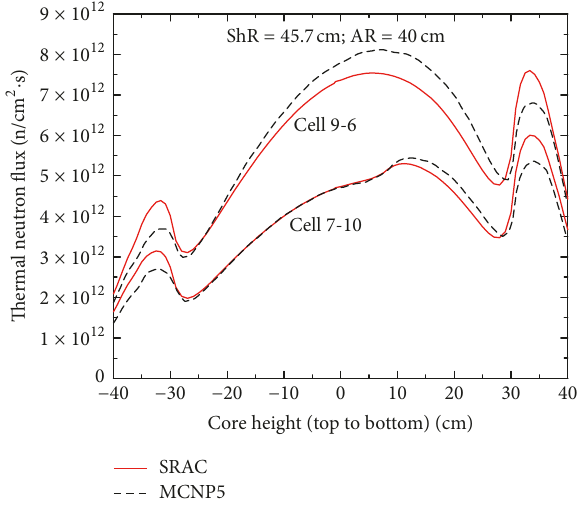
Figure12:Thermalneutronfluxdistributionalongtheneutrontrap. Rods in: ShR = 45.7 cm and AR = 40 cm; Rods out: ShR = 0 cm and AR =